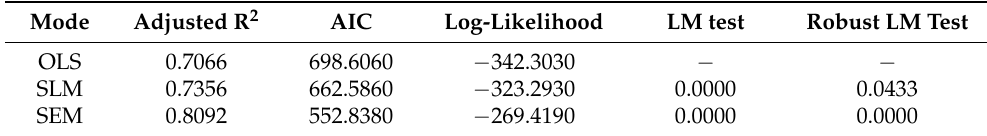
Table 3. Comparison of OLS, SLM, and SEM models.